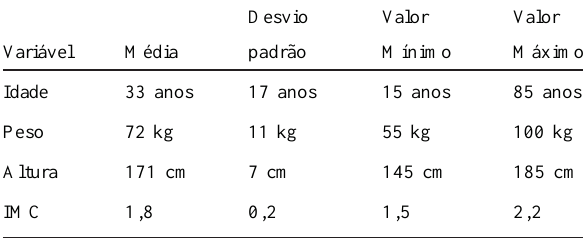
Tabela 1. Tabela de caracterização da casuística.